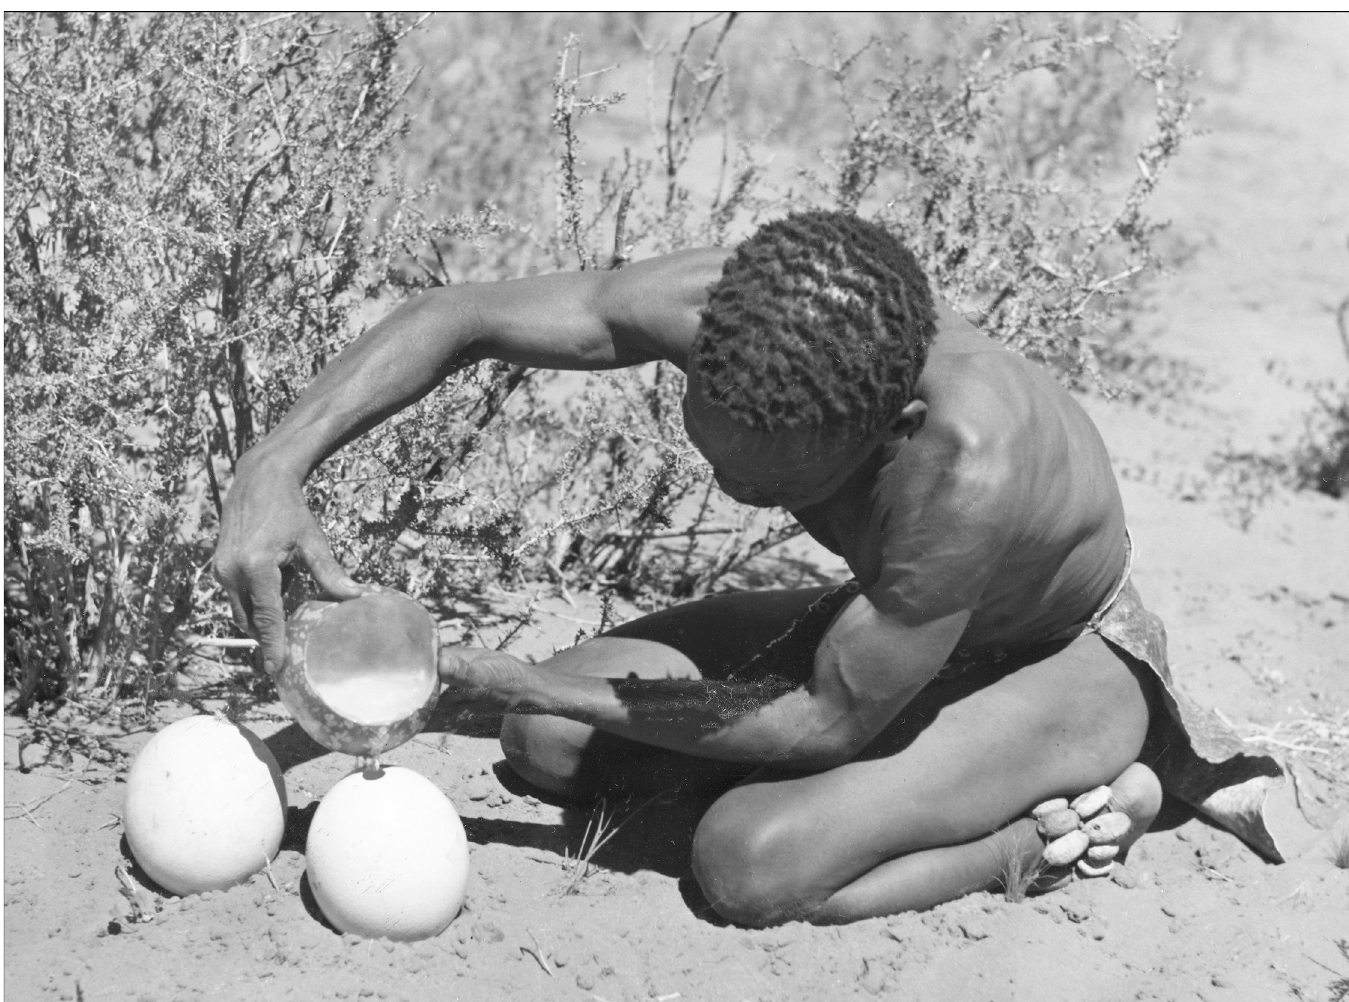
Fig 10. Man filling ostrich eggshells with water for storage, 1945–50, Southern Africa. Copyright Pitt Rivers Museum, University of Oxford